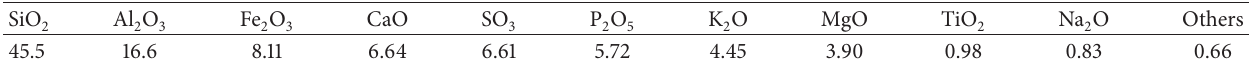
Table 4: The chemical constituents of SSA (%).